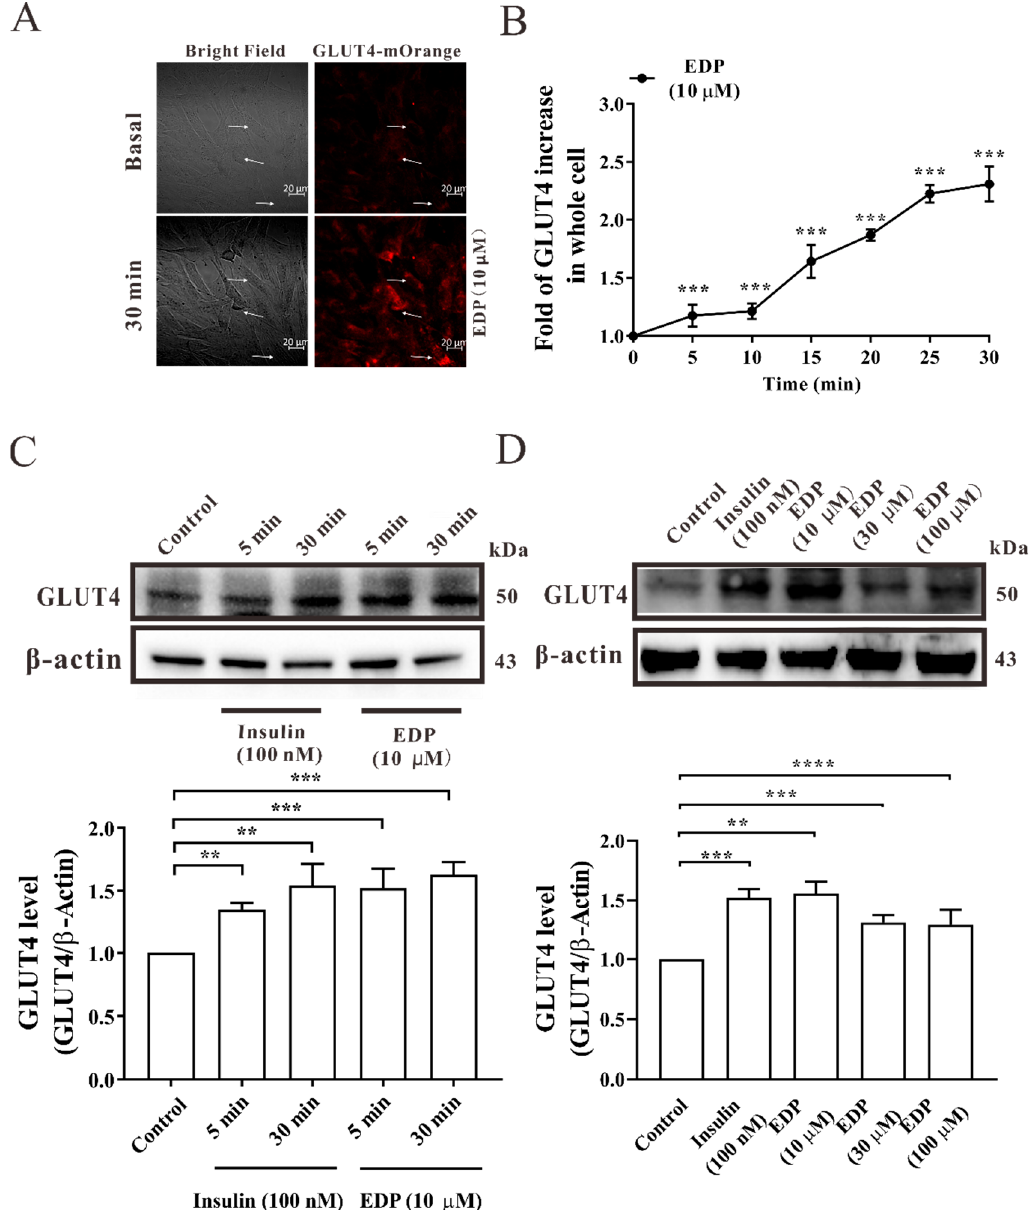
Figure 2. Estradiol Dipropionate (EDP) promotes GLUT4 expression. ( A ) Treatment with 10 μ M EDP for 30 min significantly increases GLUT4 expression. Scale bar = 20 μ m. ( B ) Images of EDP stimulating GLUT4 expression occurred in a time-dependent manner, n = 30 cells. ( C ) Effect of insulin and EDP treatment on GLUT4 protein expression in different time gradients. ( D ) The expression of GLUT4 induced by EDP at different concentration gradients was detected by Western blot. ** p < 0.01; *** p < 0.001; **** p < 0.0001.